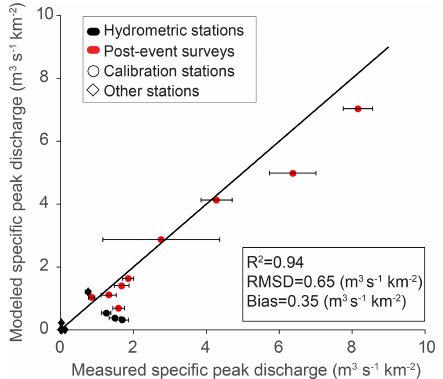
Figure 5. Measured vs. modeled specific peak discharge and er- ror metrics for 12 peak discharges during the 3d period of the storm. Horizontal error bars represent measured peak discharge un- certainty. Subbasins considered in the calibration process are from the eastern side of the catchment (Fig.